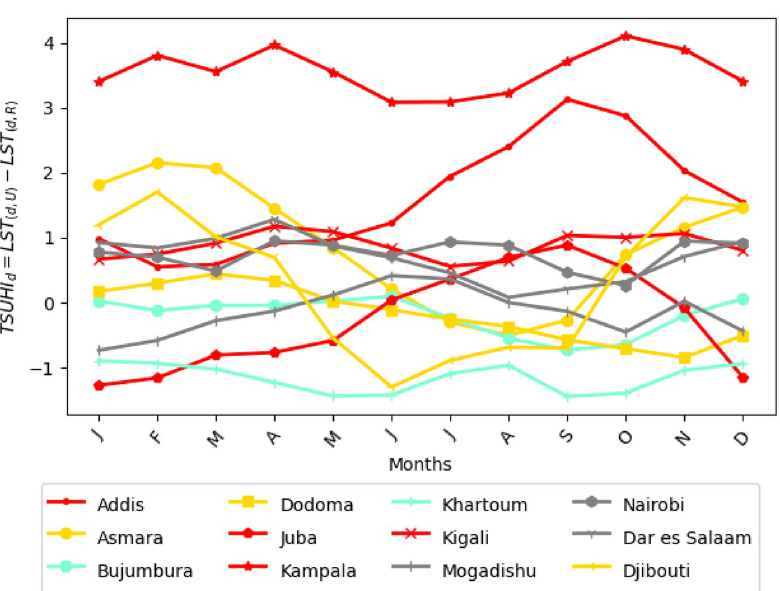
Figure 6. Seasonal cycle of tropical surface urban heat islands (TSUHIs) in the greater horn of Africa during the day. Different markers are used to differentiate the lines and the same colors are used for cities identified to have the same seasonal characteristics of the tropical surface urban heat